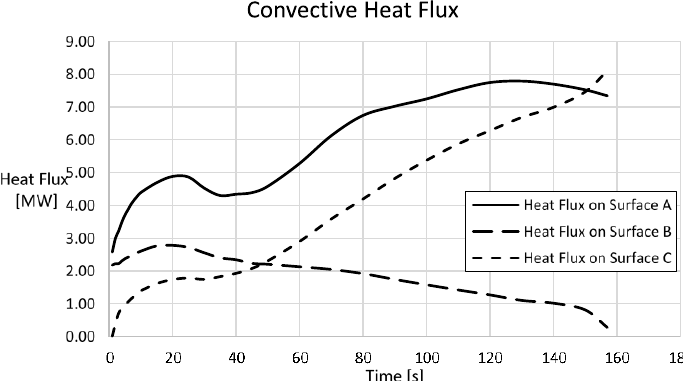
Figure 10. The convective heat flux evaluated in the three control surfaces created for a complete opening of the door of 4.7 m.